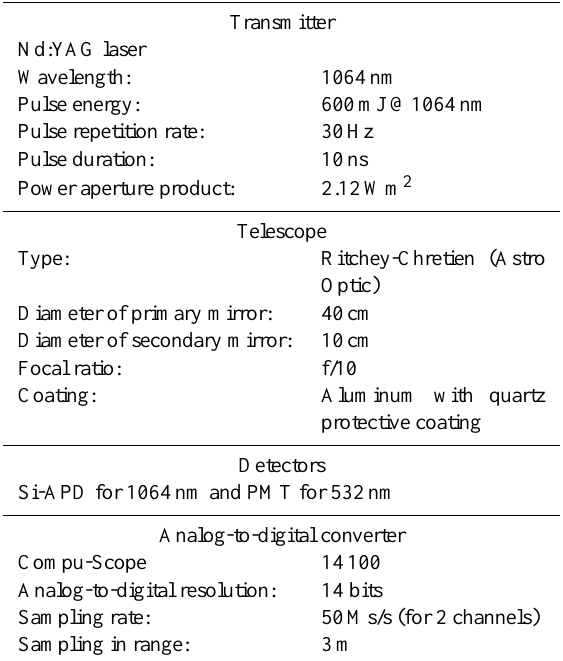
Table 1. Technical parameters of the vertically-pointing UHOH elastic aerosol lidar